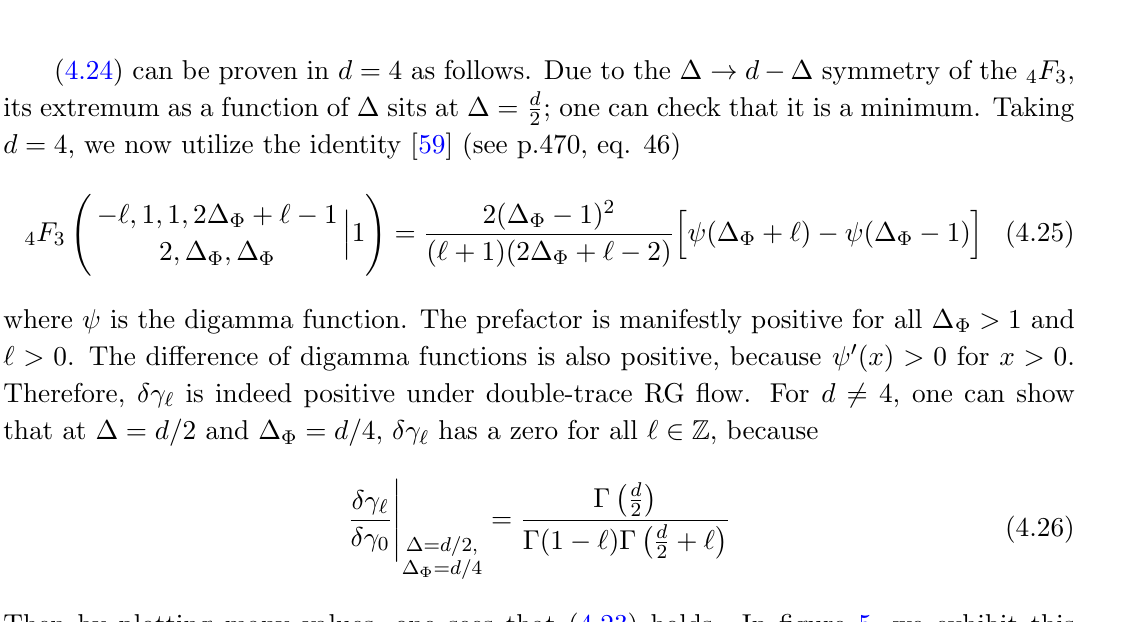
Figure 5 . In d = 3, a plot of (cid:14)(cid:13) ‘ evaluated at (cid:1) = 3 = 2, its minimum, as a function of (cid:1) (cid:8) . We plot ‘ = 2 ; 4 ; : : : ; 16, where red is ‘ = 2 and the spin increases as we move through the